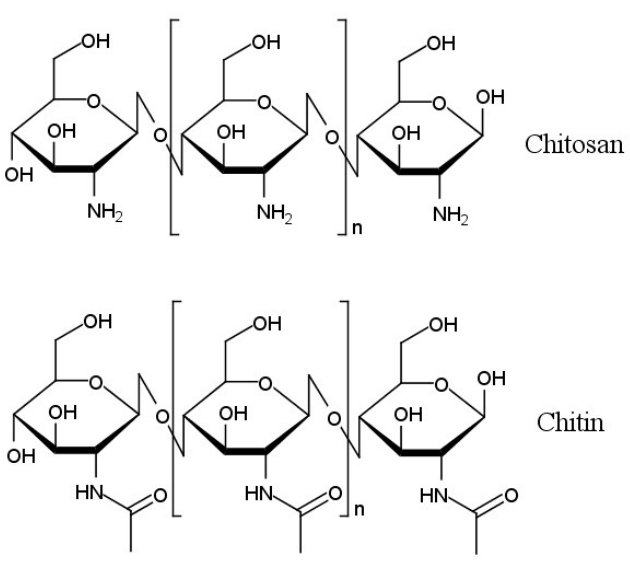
Figure 1. Structural formulas of chitosan and chitin.